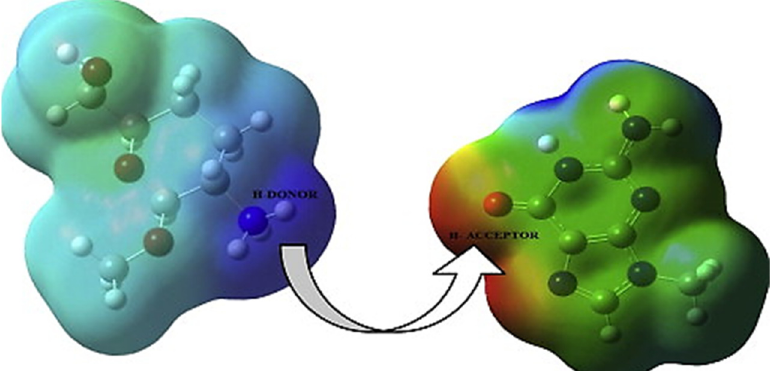
Figure 10. MEP isosurface diagram of the complex model for chitosan and guanine. Reproduced with permission from ref. [34]; Copyright 2015, Elsevier Science Ltd.